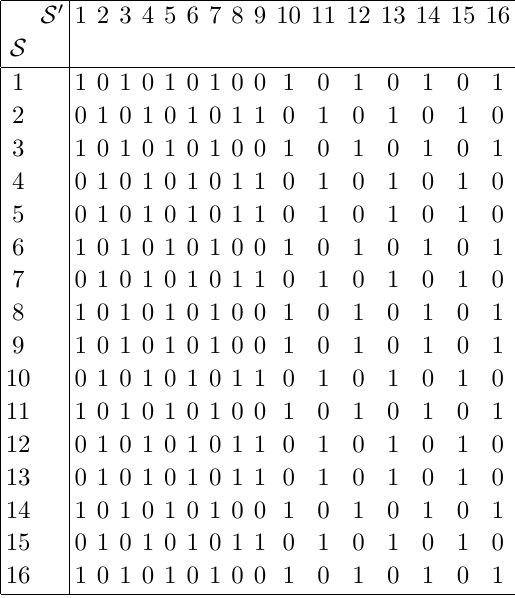
(cid:2) P with di(cid:11)erent boolean factors. [2] [6]